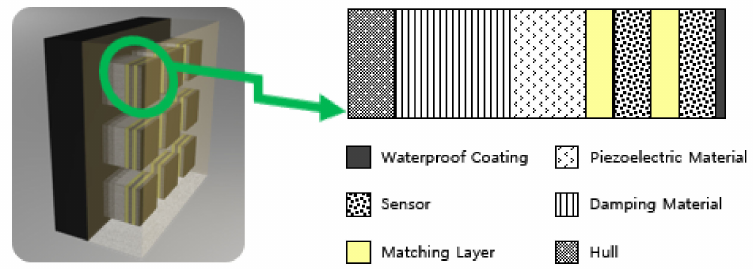
Figure 1. Concept of the smart skin system.